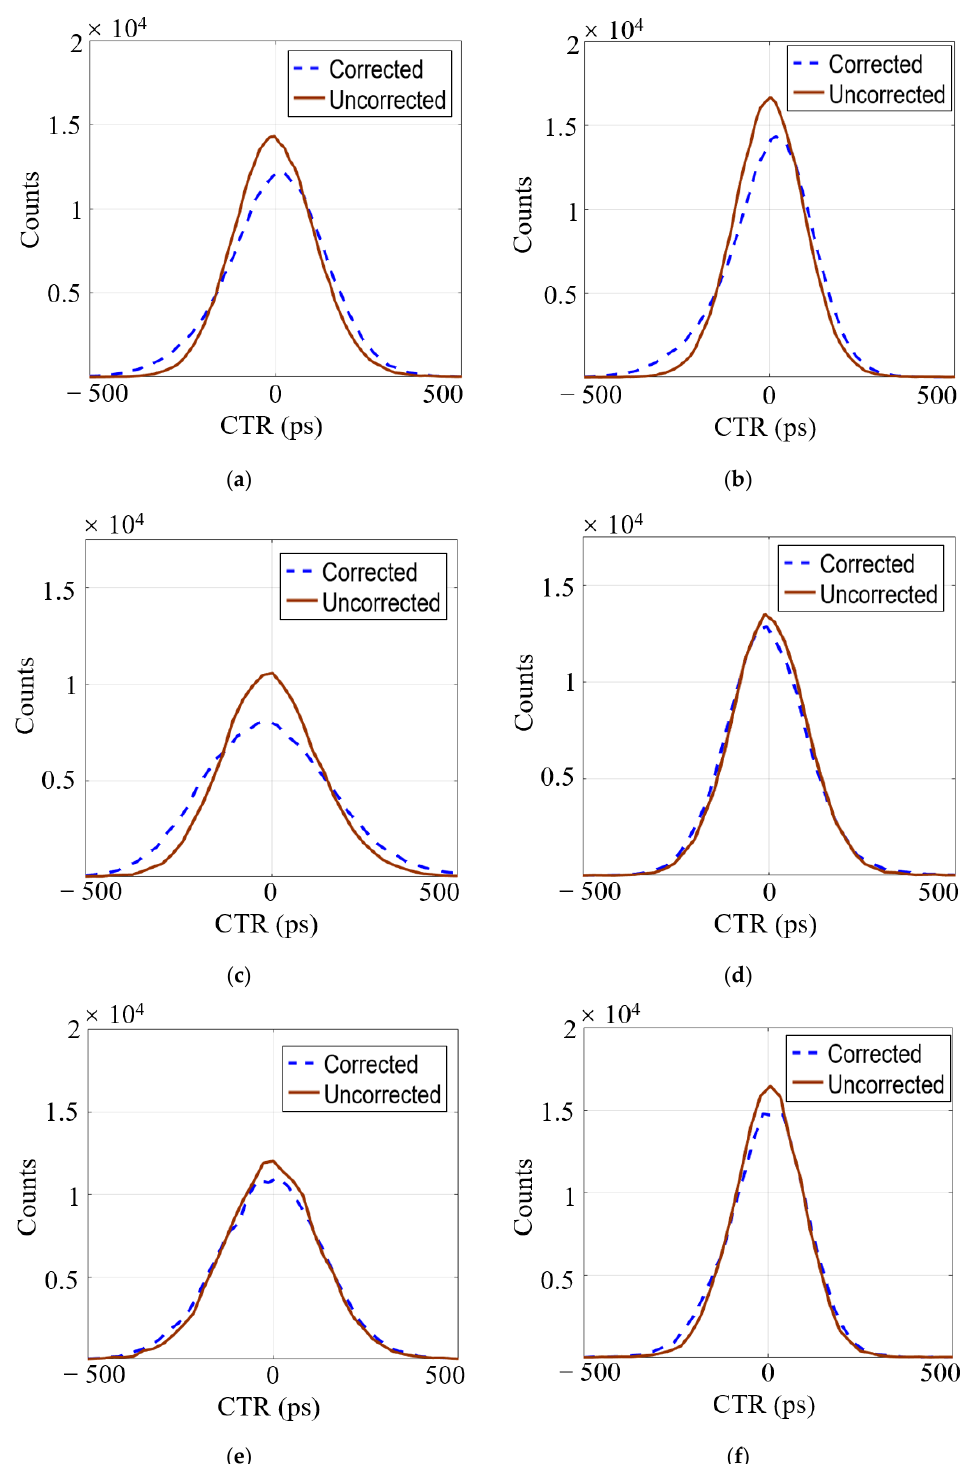
Figure 10. Time spectrum of ( a ) ∆𝑇 1 and ( b ) ∆𝑇 12 of the dual-ended readout; ( c ) ∆𝑇 1 and ( d ) ∆𝑇 12 of the side dual-ended readout; ( e ) ∆𝑇 1 and ( f ) ∆𝑇 123 of the triple-ended readout.